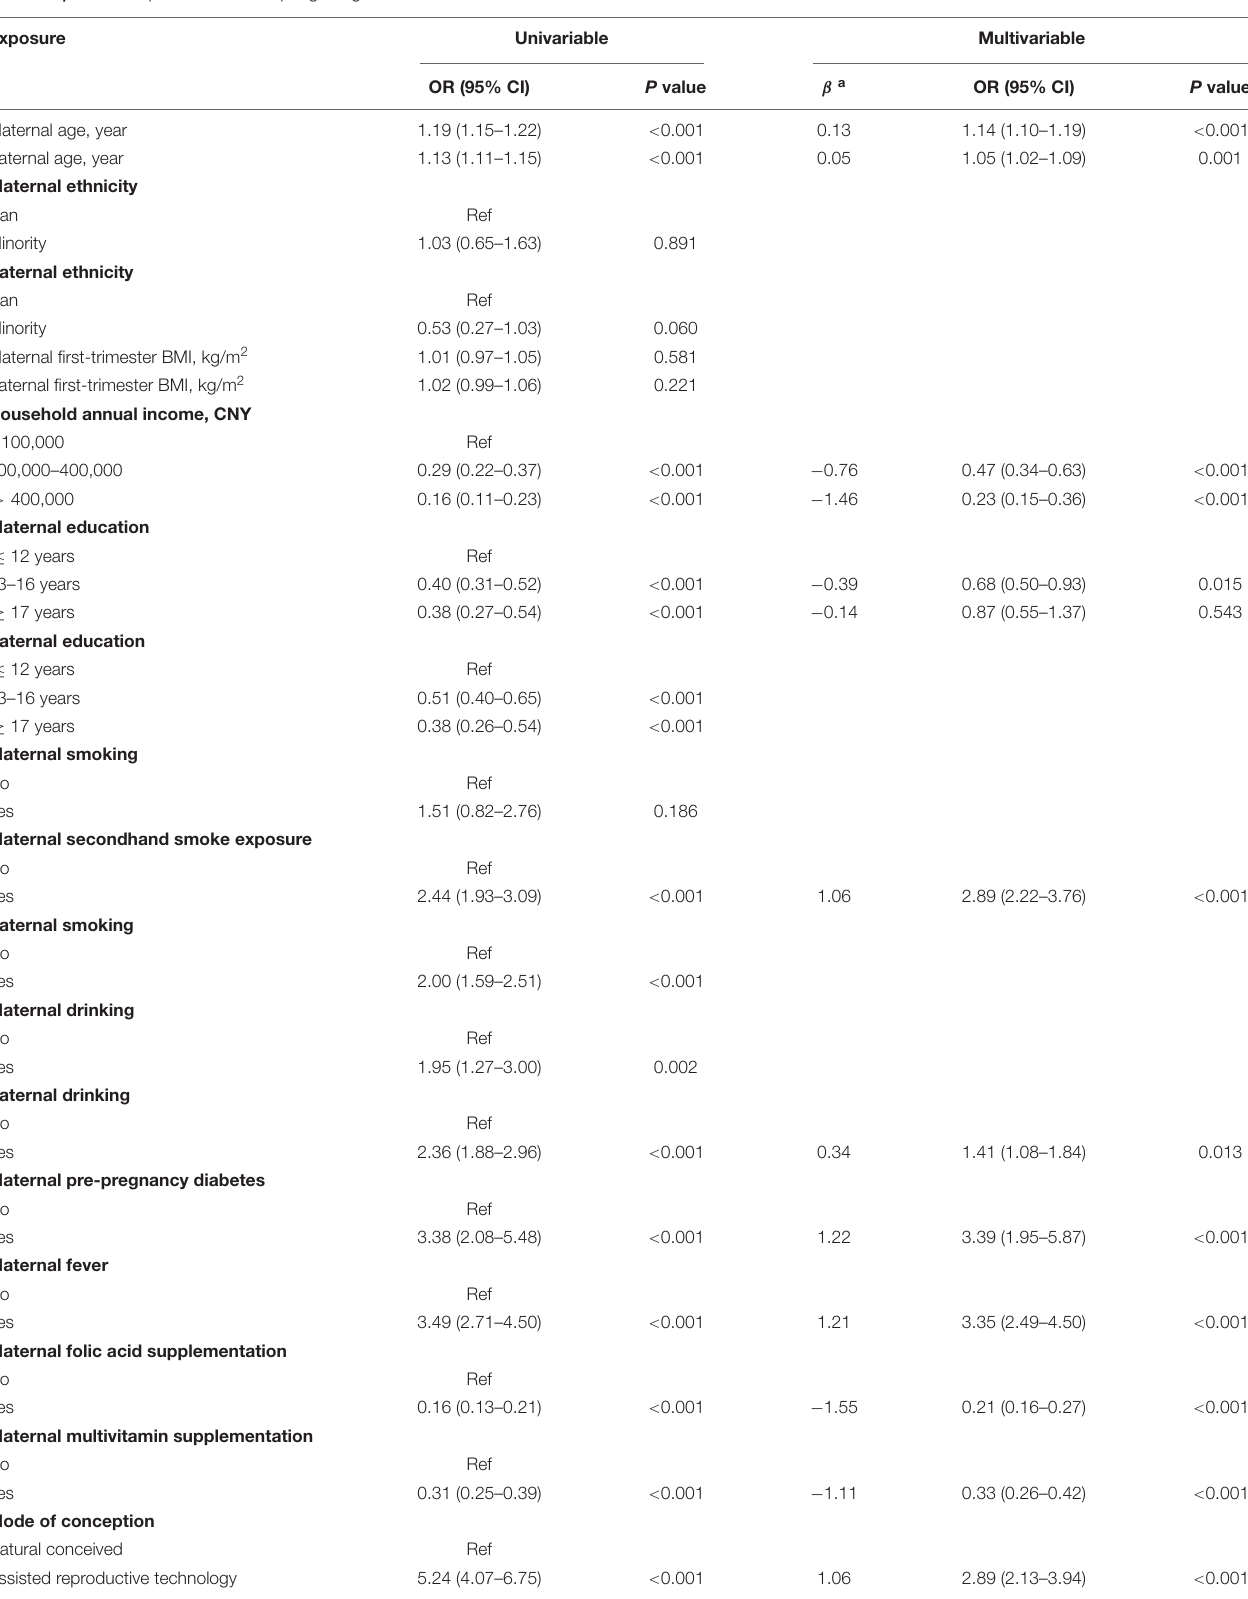
TABLE 2 | Dominant predictors for offspring congenital heart disease. Exposure Univariable